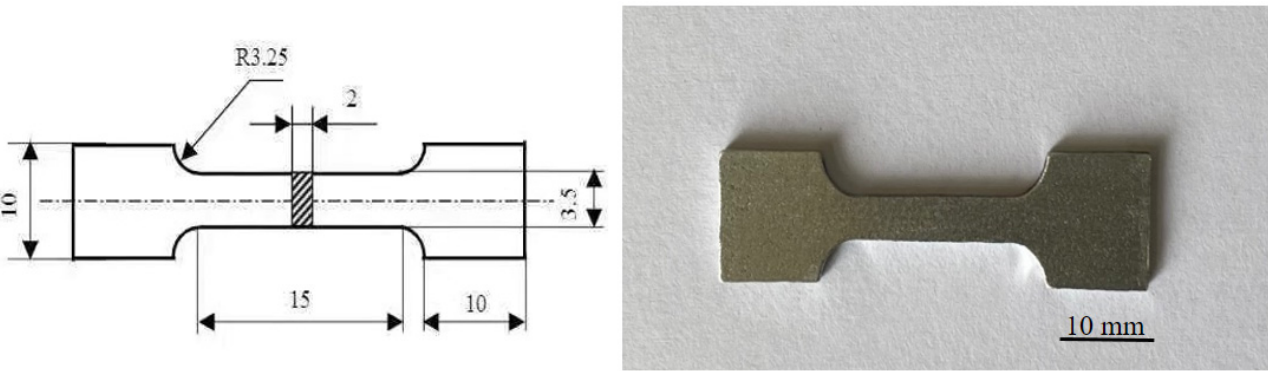
Figure 5. Dimensional drawing of tensile specimen and real